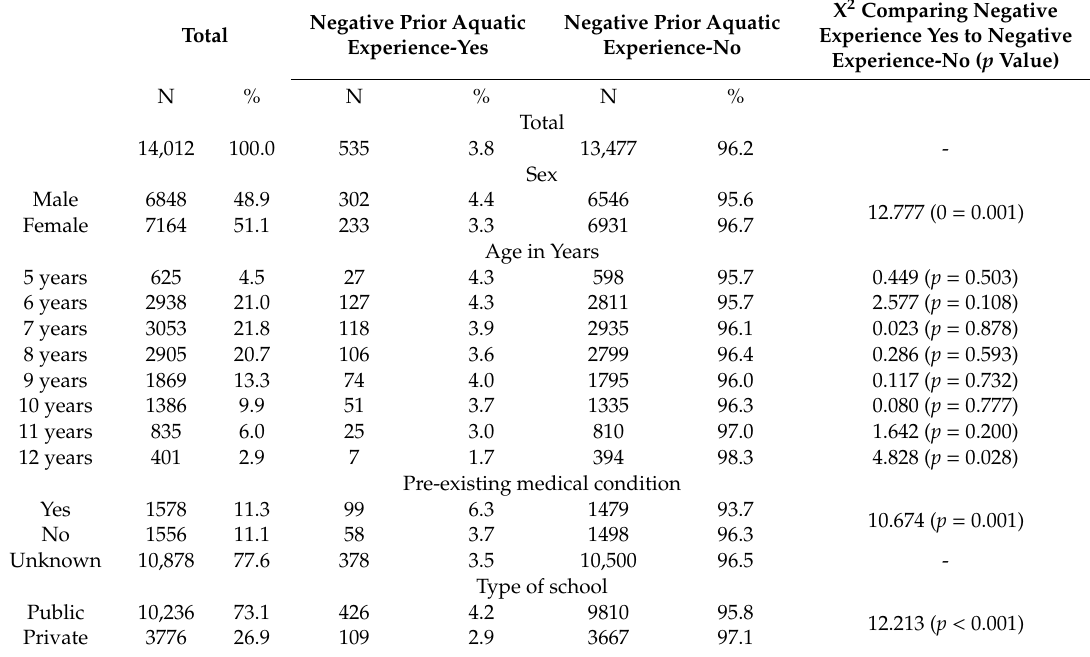
Table 2. Demographics of participants by negative prior aquatic experience yes / no, chi square ( p value), Australian Capital Territory (ACT), 20092012-(N =